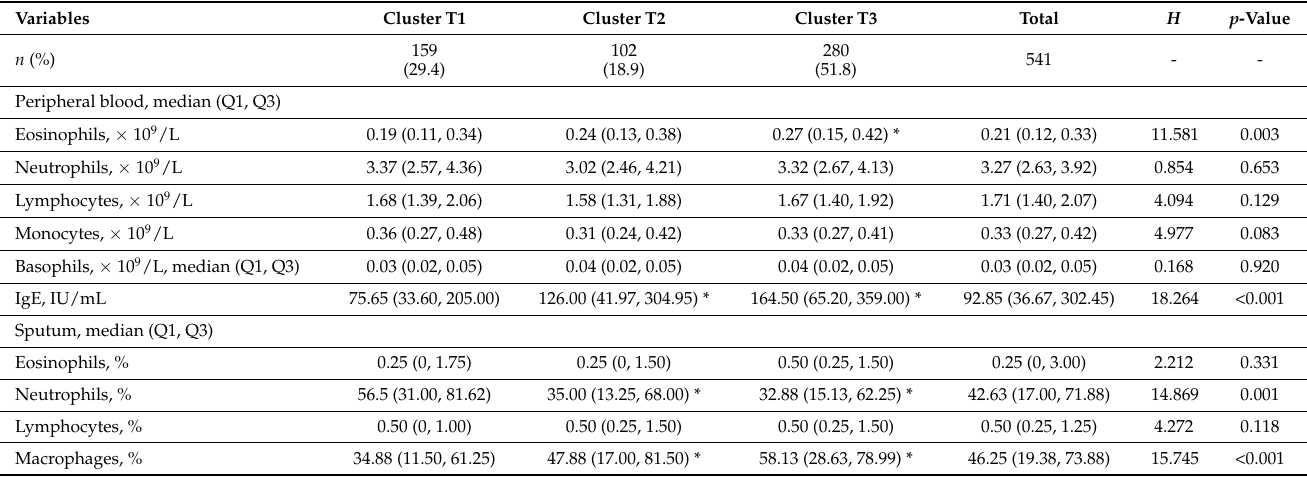
Table 2. Inflammatory characteristics of the included patients with asthma grouped by cluster analysis in the training